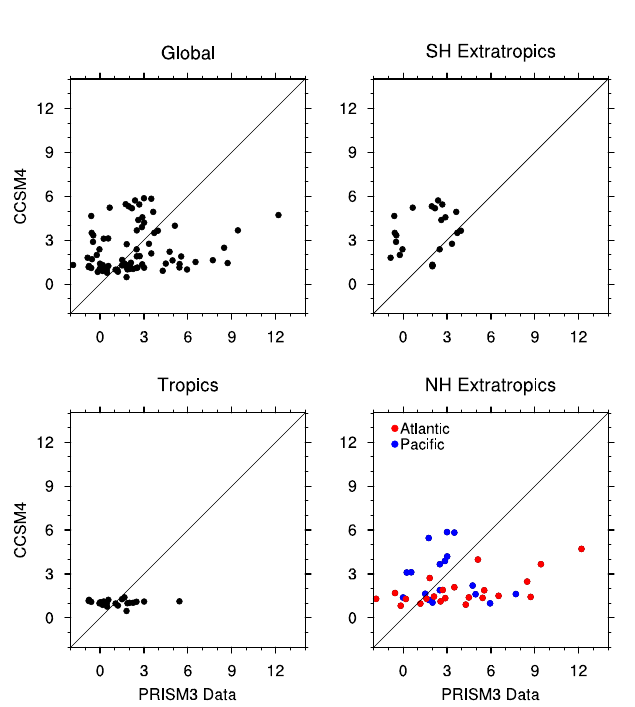
Fig. 10. PRISM3 reconstructed annual SST plotted against CCSM4 mPWP annual SST for the same latitude/longitude grid cell.